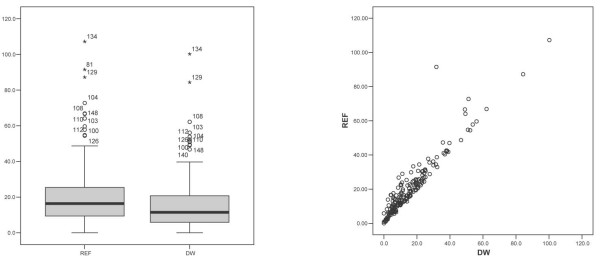
incmandal. Boxplots of IREF and IDW (left) and scatter plot of IREF vs. IDW (right), showing that IREF >IDW.